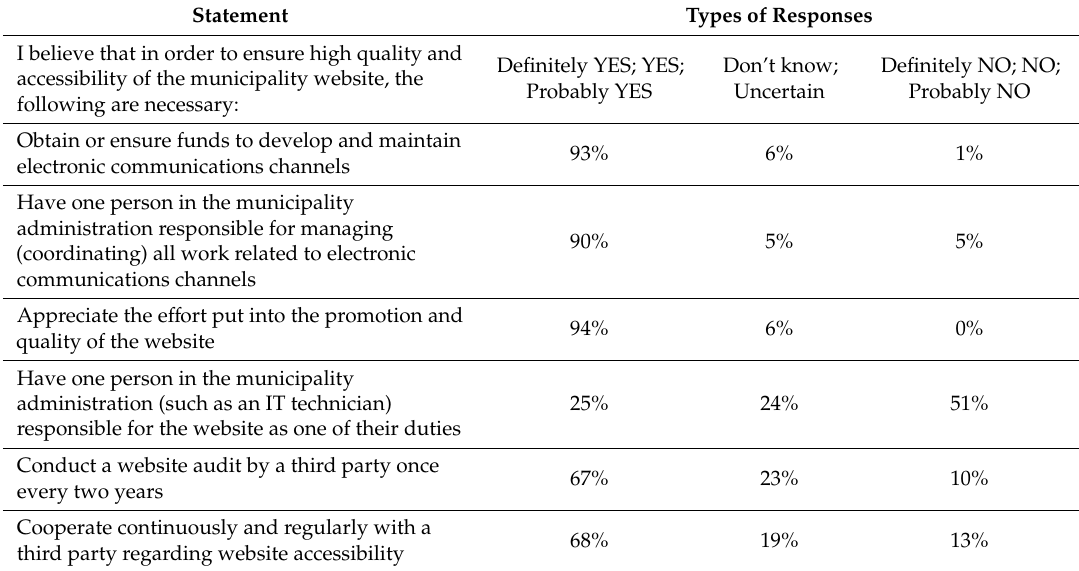
Table 9. Survey results: ‘organizational solutions’ ( n =